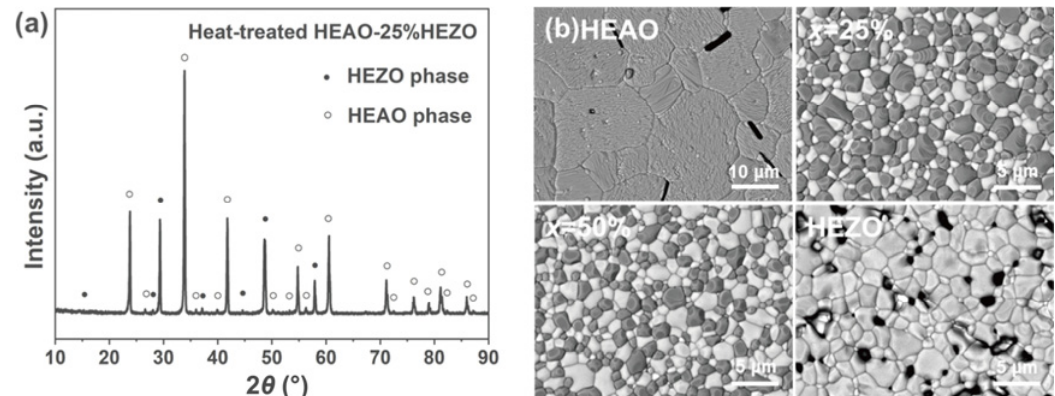
Fig. 7 Phase compositions and microstructures of HEAO-based particulate composites after heat treatment at 1773 K for 20 h. (a) XRD pattern of HEAO–25%HEZO particulate composite and (b) SEM images of x = 0, 25%, 50%, and 100%